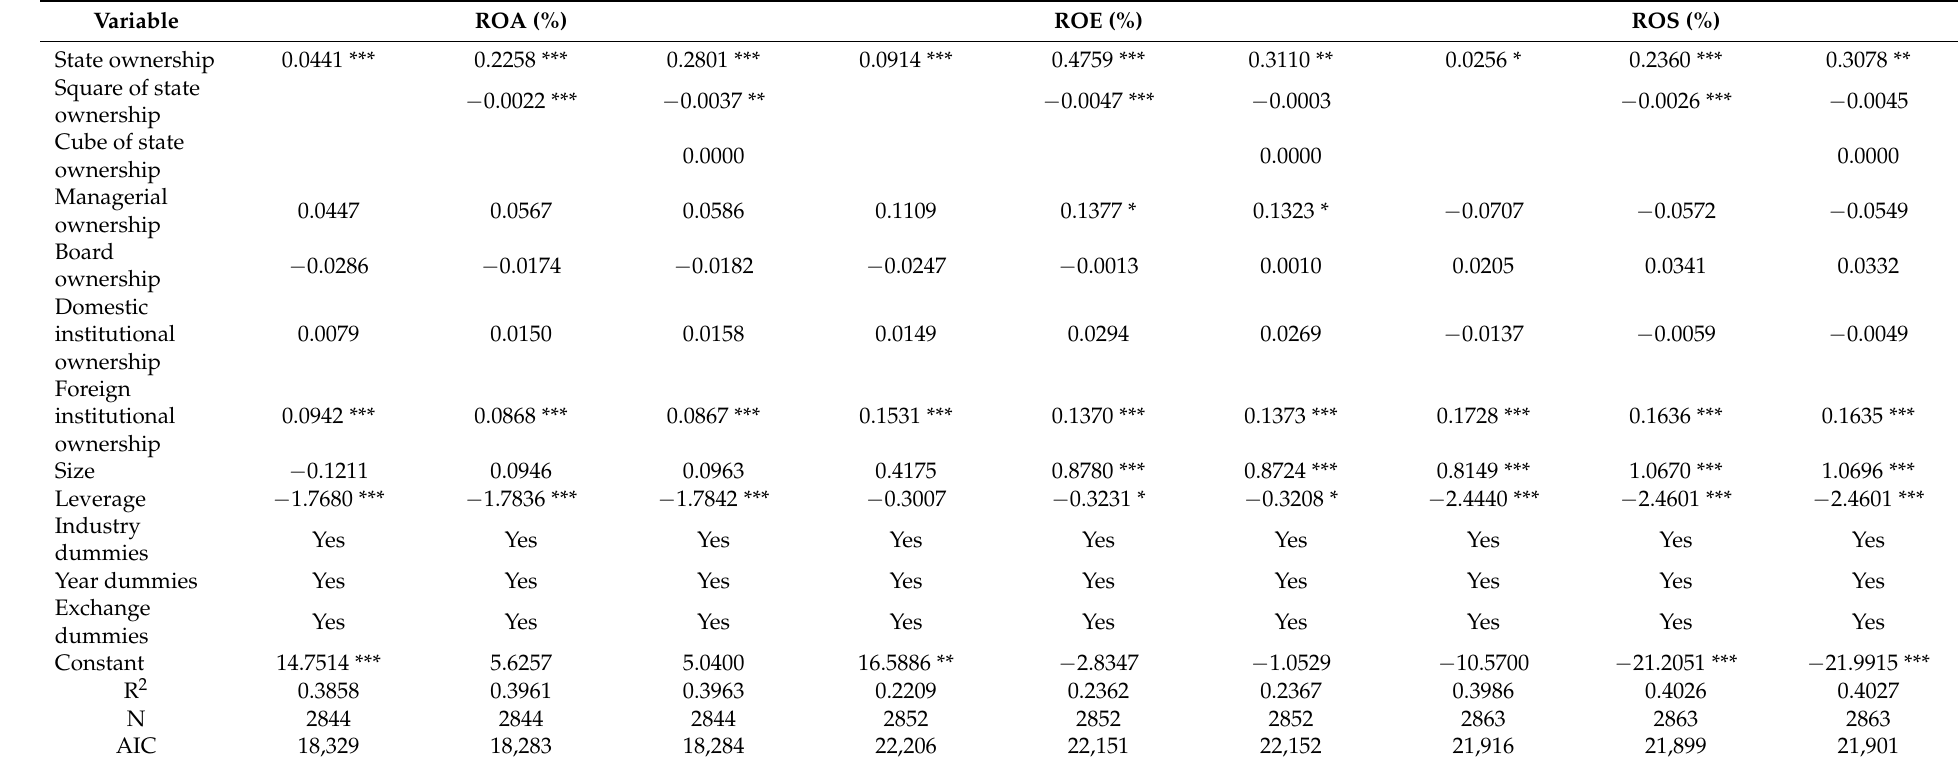
Table A2. Linear, quadratic, and cubic regressions of partially privatized firm profitability on residual state